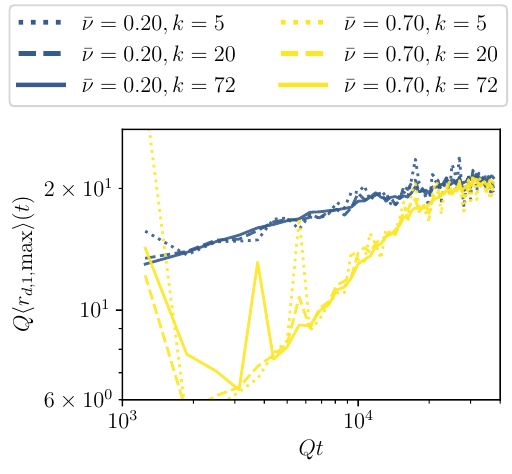
Figure 18: The average maximum death radius of 1-dimensional persistent homology classes varying with time, displayed for ¯ ν -values and numbers of samples to average, k , as